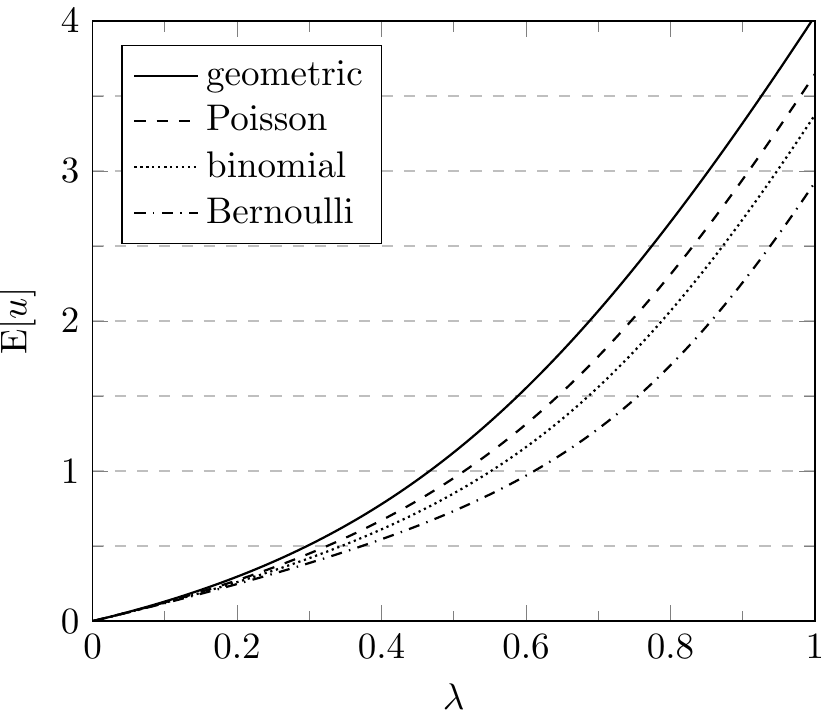
Figure 9. Mean system content E [ u ] versus λ for geometric service times with µ = 0.75, σ = 0.1 and various distributions for the number of arrivals per slot.